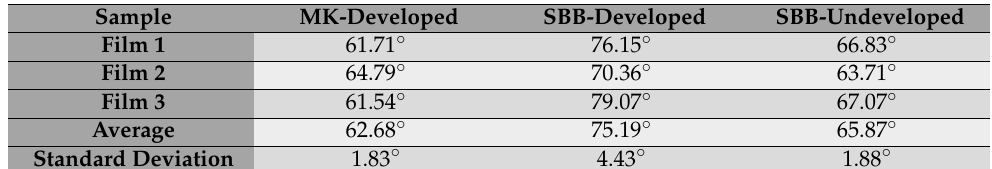
Table 2. Average values and standard deviations of contact angle measurements of thin films of both resins used in this work. (MK—Michler’s ketone, SBB—Sudan Black